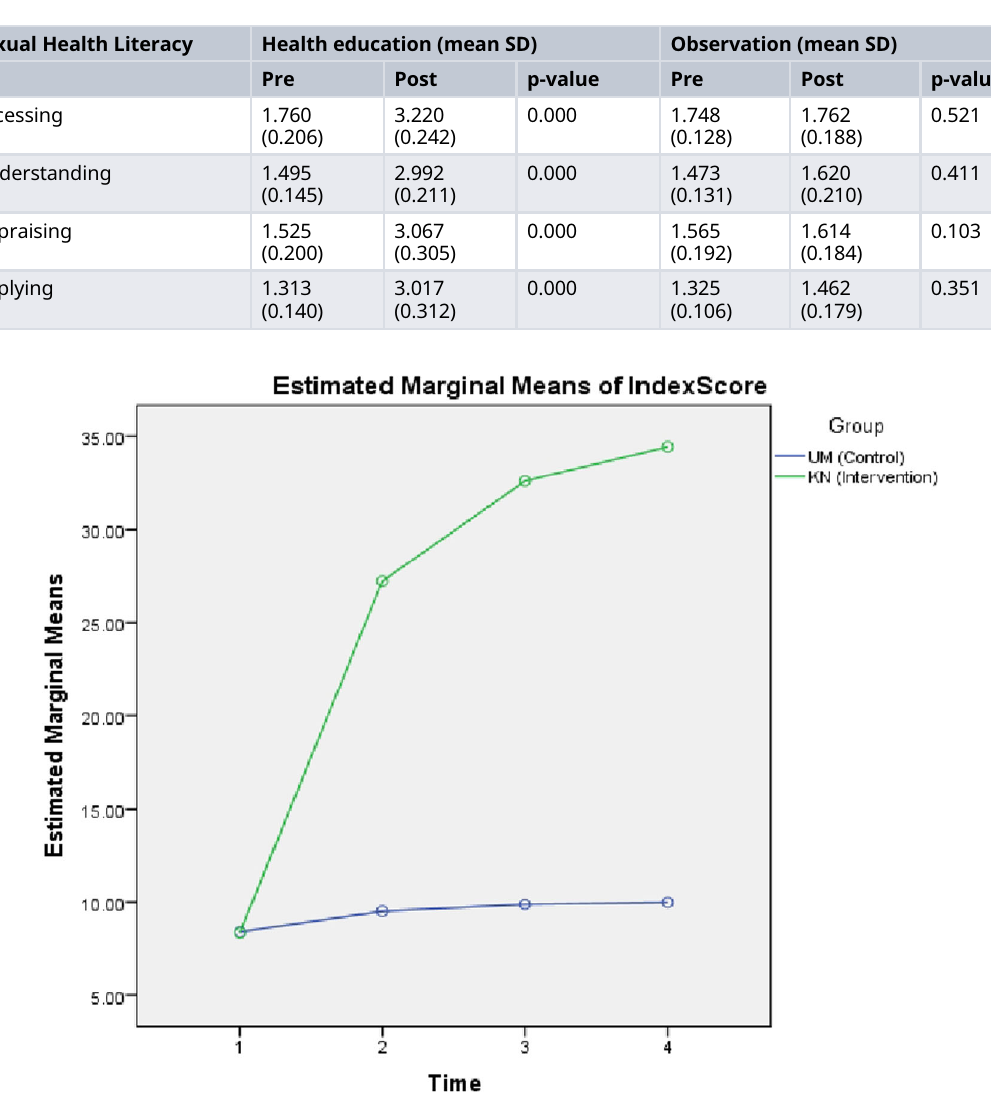
Figure 1. Estimated marginal means of index